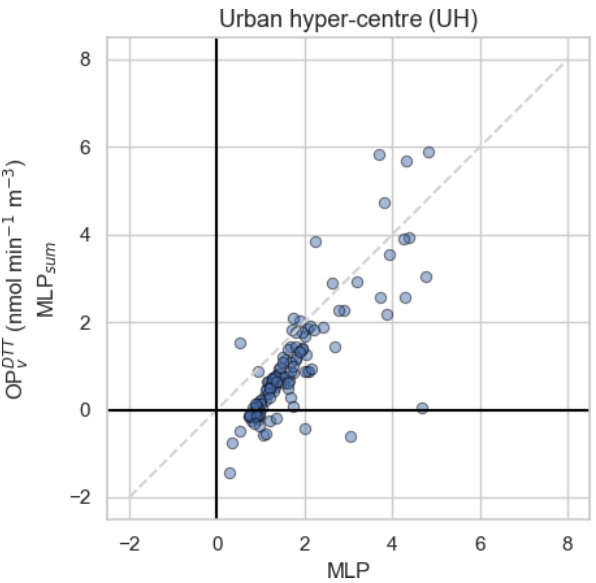
Figure 8. The comparison of the original modelled OP DTT v (MLP) and the sum of source-specific modelled OP DTT v activity. Note: dashed grey line corresponds to the 1 : 1 line. Data points below the 1 : 1 line show an overall synergistic effect between PM 10 sources on OP activity; above the 1 : 1 line it is